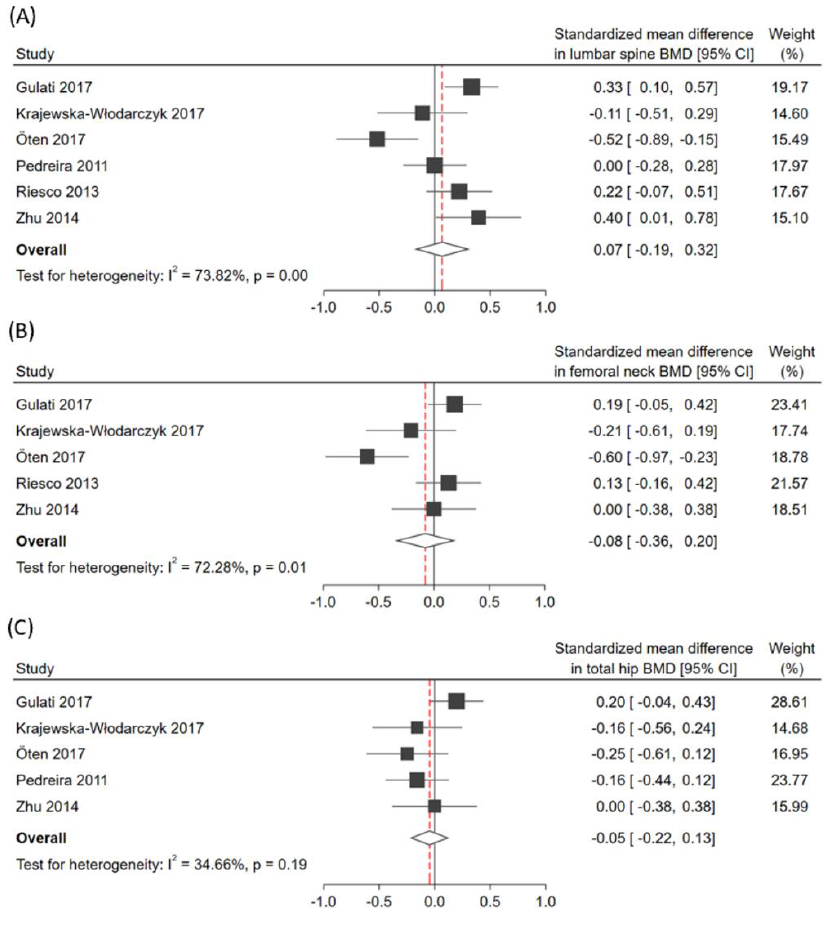
Figure 2. Forest plots of the standardized mean difference (SMD) in absolute bone mineral density. The plots are presented in subgroups of ( A ) lumbar spine, ( B ) femoral neck, and ( C ) total hip. CI, confidence interval.